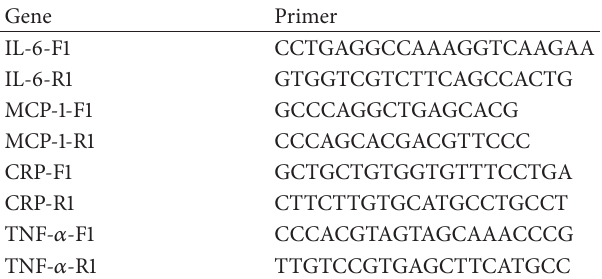
Table 1: PCR primer